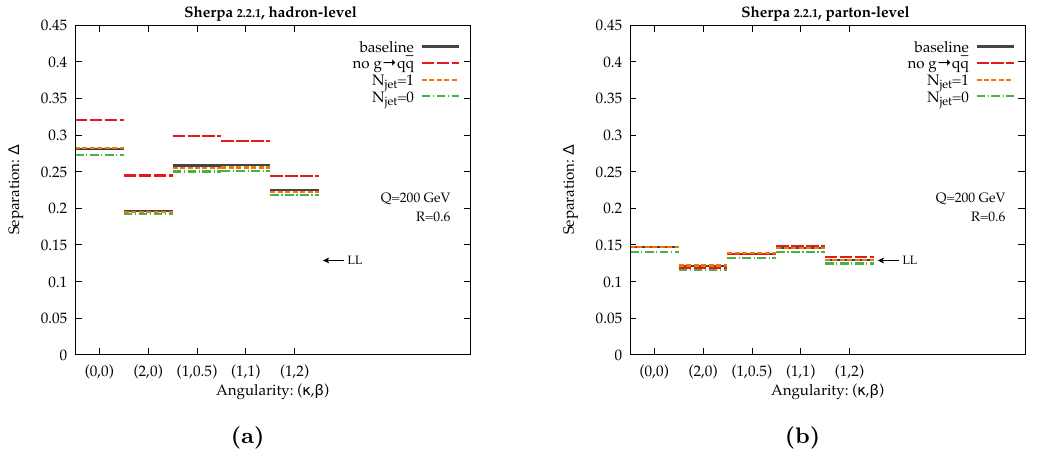
Figure 11. Same as (cid:12)gure 9, but for Sherpa 2.2.1 .